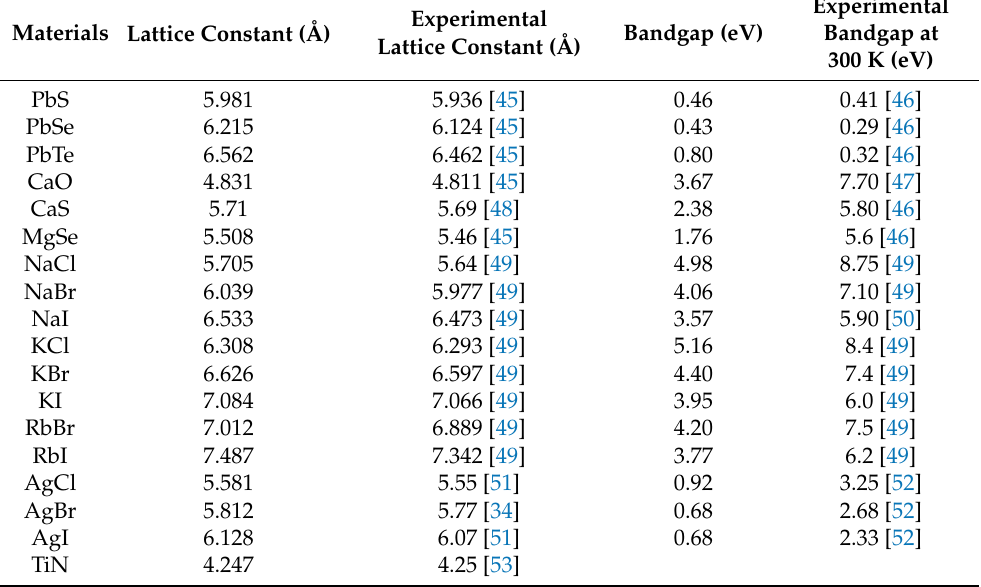
Table 1. Calculated lattice constants (in Å) and bandgaps (in eV) of optimized unit cells for selected rock-salt materials.